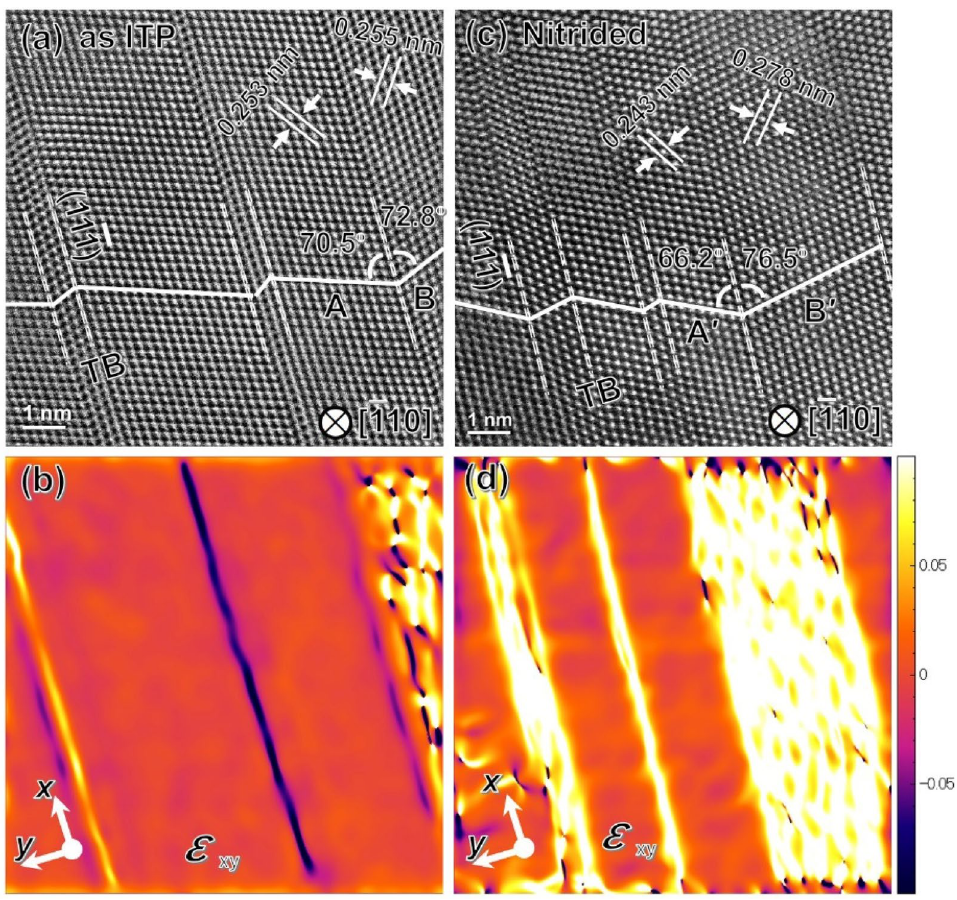
Figure 4. Shear stress induced lattice distortion and incoherence at the nanotwinned region. ( a , c ) High- resolution HAADF-STEM images demonstrating parallel multi-nanotwin TBs along the ( 111 ) plane are indicated by the dashed lines and ( b , d ) corresponding GPA strain maps showing the shear strain (strain tensor component ε xy ) of the ( a , b ) as induction thermal plasma processed and ( c , d ) nitrided FeNi NPs. The colour scale bar for strain ranges from − 10% (dark blue) to + 10%